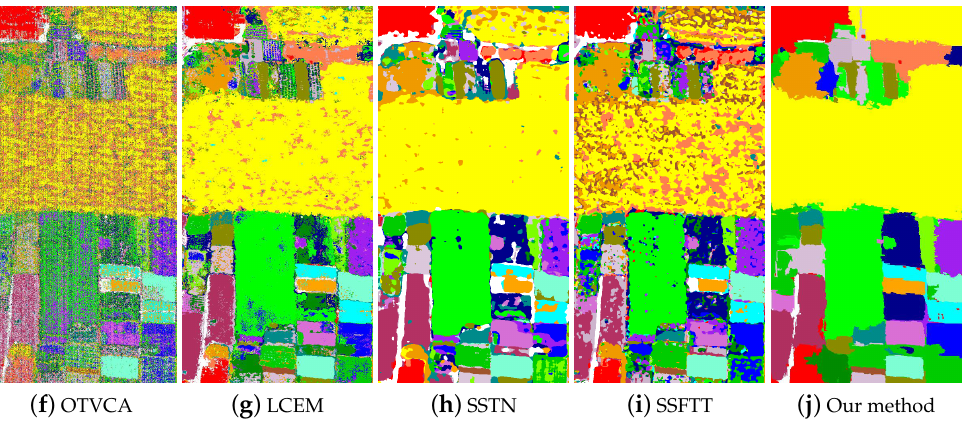
Figure 7. Classification maps of different classification methods on the Honghu dataset. ( a ) SVM [11], OA = 54.21%. ( b ) EMAP [38], OA = 65.37%. ( c ) SCMK [39], OA = 81.17%. ( d ) PCAEPFs [40],